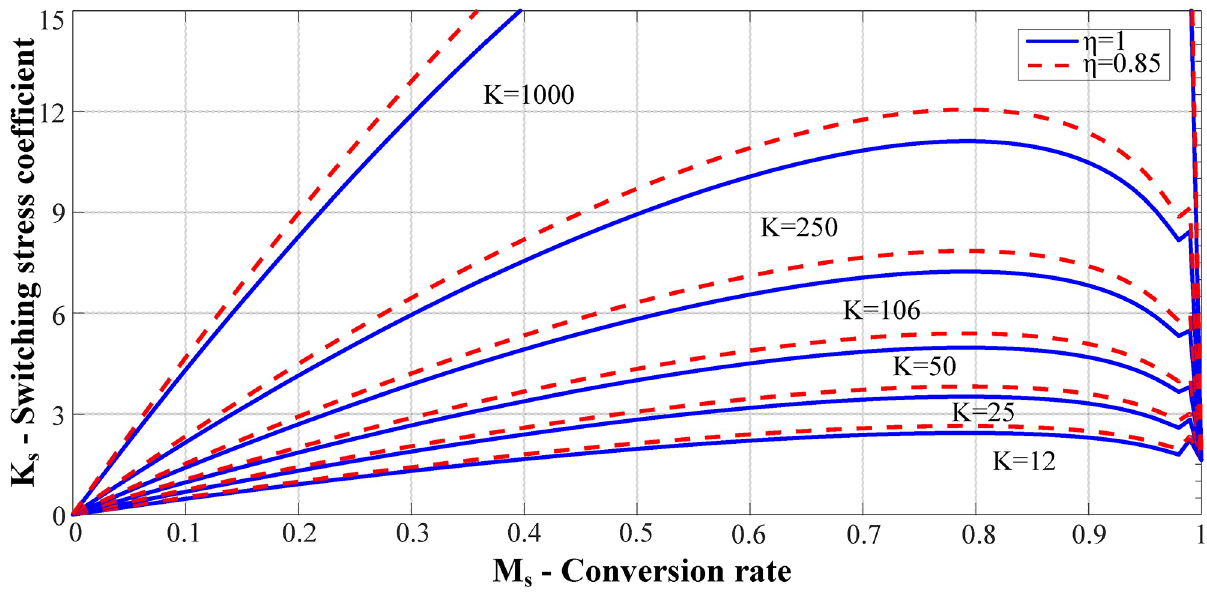
Fig 4. M s - K s curve under different parameter K and η .